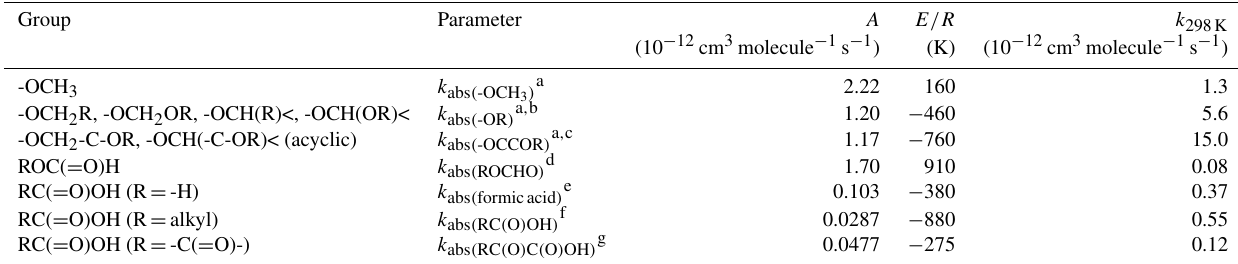
Table 7. Arrhenius parameters ( k = A exp ( − (E/R)/T ) ) for the rate coefficients for H-atom abstraction from carbon atoms adjacent to oxygen linkages in mono-ethers and di-ethers; from the formyl group in formate esters, and from the carboxyl group in carboxylic acids, and their values at 298K. These values are applied independently of neighbouring group substituent factors.